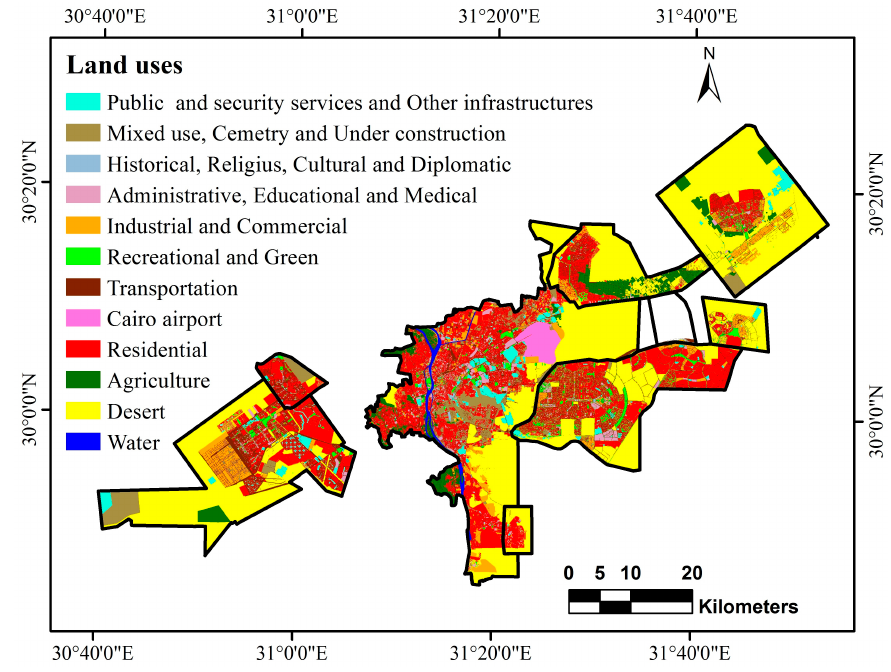
Figure 2. Land use map of Cairo and its NT (New Towns) (without built-up area of El-Shorouk because of the lack of